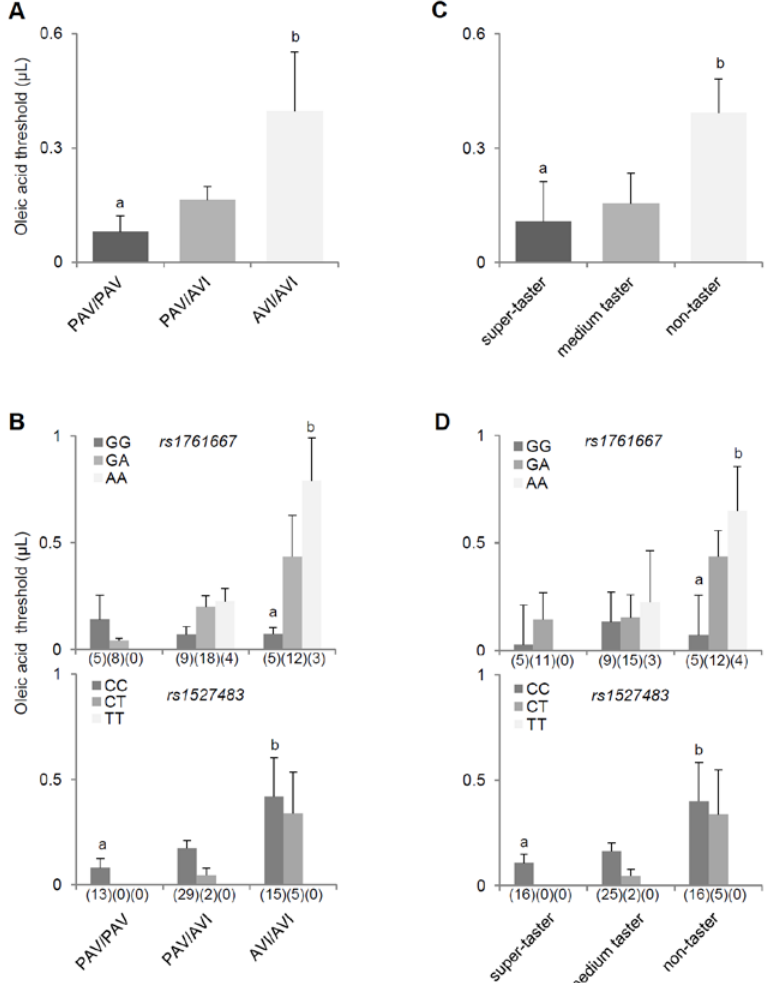
Figure 4. Relationships between flavor threshold to oleic acid, PROP genotype and phenotype, and the two polymorphism ( rs1761667 and rs1527483 ) of CD36 . ( A ) Mean values (±SEM) of the oleic acid threshold in subjects with genotype PAV/PAV ( n = 13), PAV/AVI ( n = 31), and AVI/AVI ( n = 20) of TAS2R38 . Different letters indicate a significant difference ( p = 0.035, Fisher LSD test subsequent to one-way ANOVA); ( B ) Mean values (±SEM) of the oleic acid threshold according to TAS2R38 and rs1761667 (upper graph) or rs1527483 polymorphism (lower graph) of CD36 . Different letters indicate a significant difference ( p < 0.037; Fisher LSD test subsequent to two-way ANOVA); ( C ) Mean values (±SEM) of the oleic acid threshold in PROP super-tasters ( n = 16), medium tasters ( n = 27), and non-tasters ( n = 21). Different letters indicate a significant difference ( p = 0.042, Fisher LSD test subsequent to one-way ANOVA); ( D ) Mean values (±SEM) of the oleic acid threshold according to PROP taster status and CD36 rs1761667 (upper graph) or rs1527483 polymorphism (lower graph). Different letters indicate a significant difference ( p < 0.048; Fisher LSD test subsequent to two-way ANOVA). The numbers in parenthesis below each bar indicate the number of